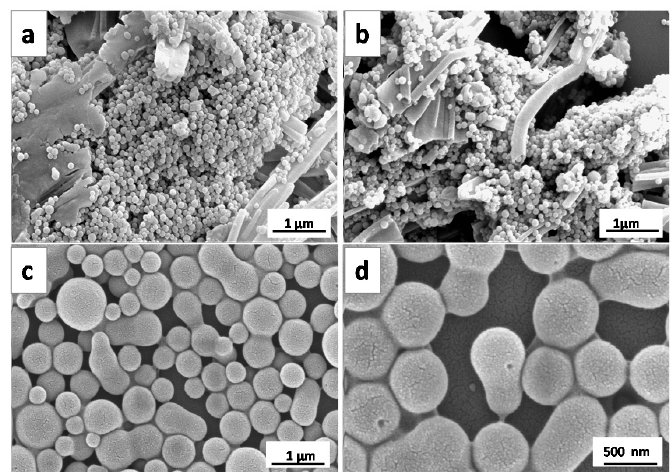
Figure 2. SEM images of a chiral PMO system prepared from ligand ( 2 ) with ( a , b ) CTAB and ( c , d ) CTAC surfactants.